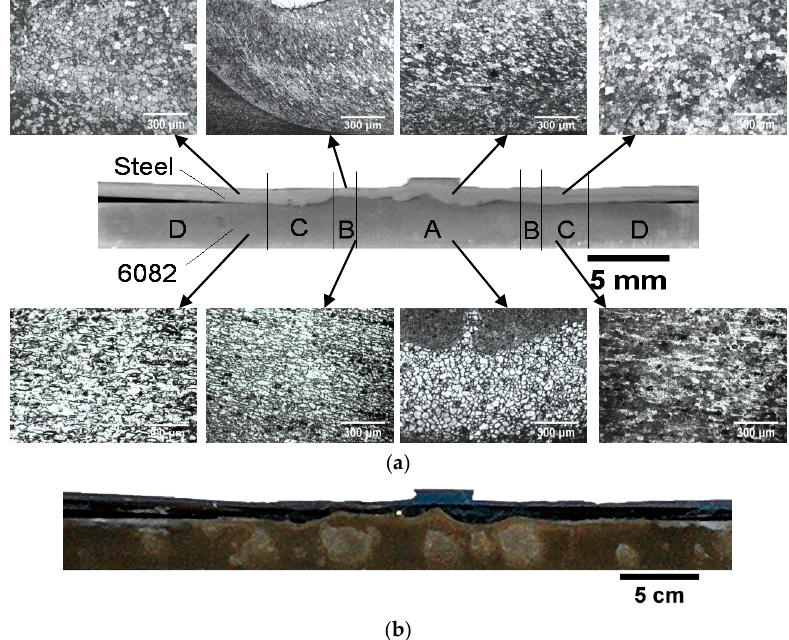
Figure 3. The optical micrographs and macroscopic corrosion morphology of the transverse section of keyhole-free FSSW joints. ( a ) The optical micrographs before immersion; ( b ) the macroscopic corrosion morphology after immersion in 3.5% NaCl solution for 48 h.